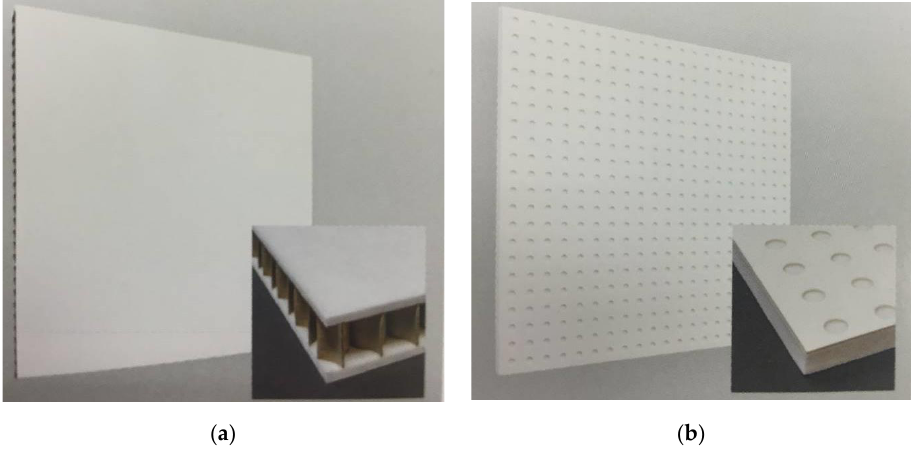
Figure 1. Sound absorption panels used in the experiment; ( a ) Type A paper with honeycomb structure; ( b ) Type B paper with perforated cardboard on the surfaces.